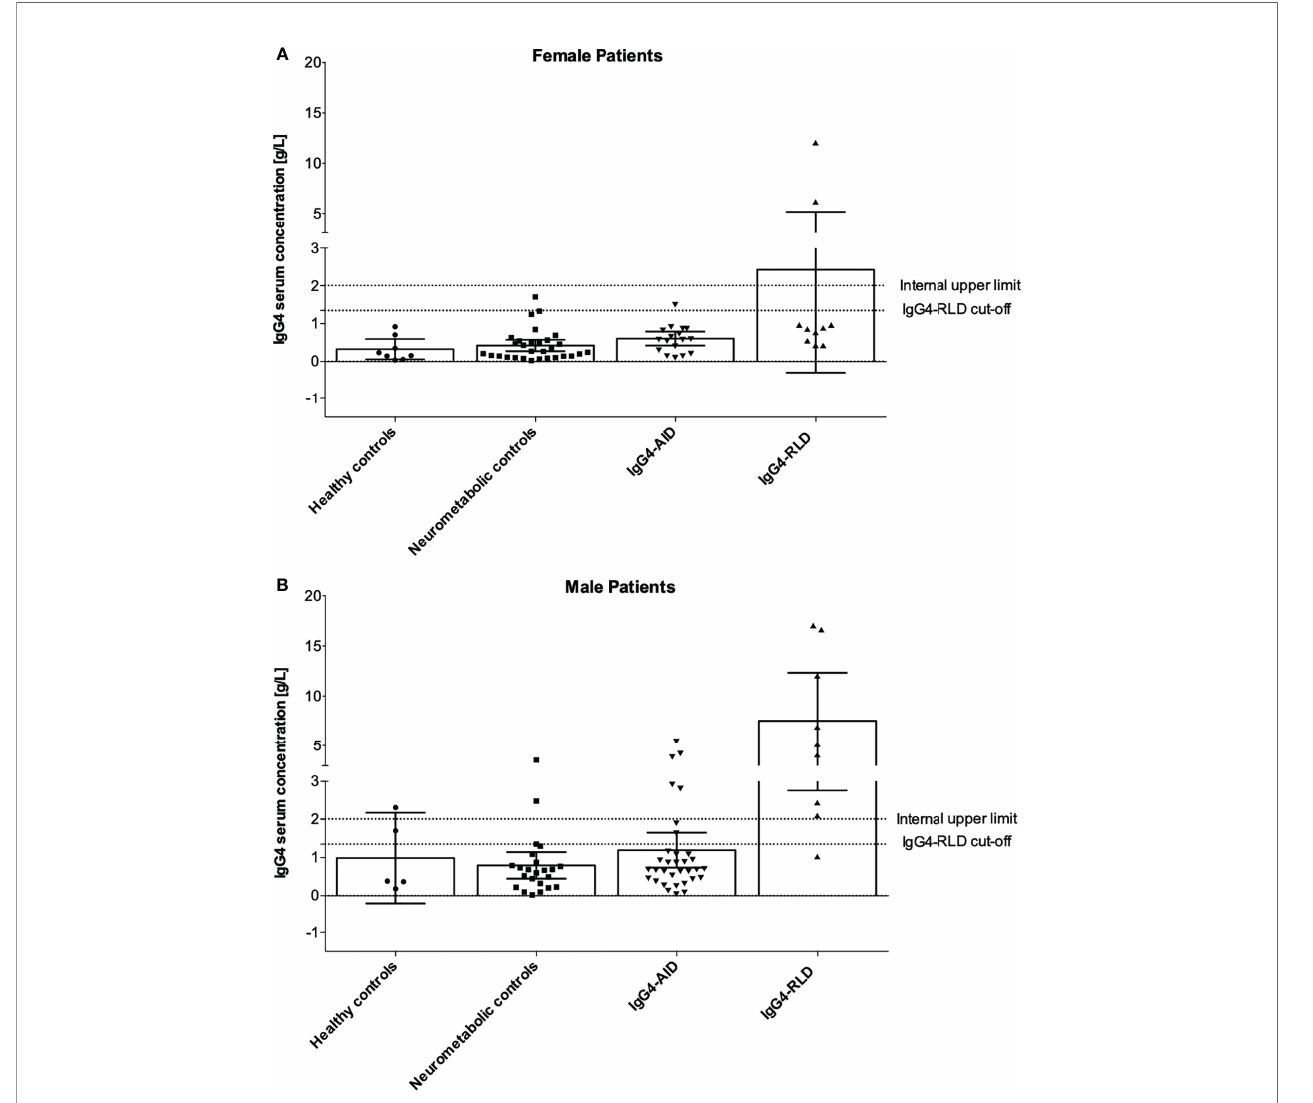
FIGURE 4 | Gender-speci fi c serum IgG4 concentrations. (A) Serum IgG4 concentrations in female patients, (B) Serum IgG4 concentrations in male patients. Bar graphs indicate mean, error bars indicate 95% CI. IgG4, immunoglobulin type G subclass 4; IgG4-AID, IgG4 autoimmune disease; IgG4-RLD, IgG4-related disease.